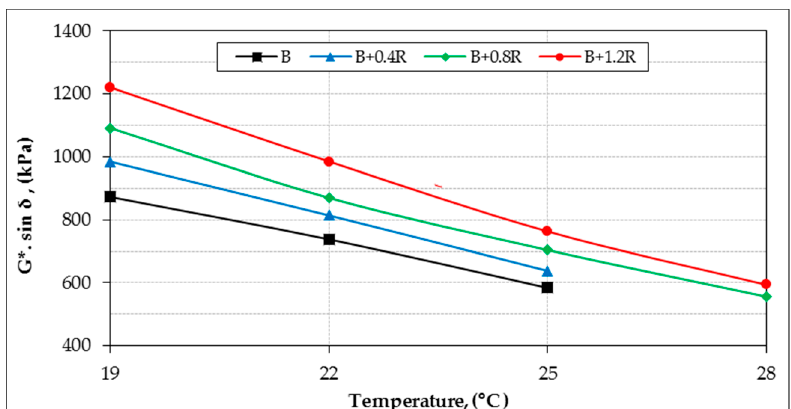
Figure 13. The G*/sin δ and temperature relationship of binders.